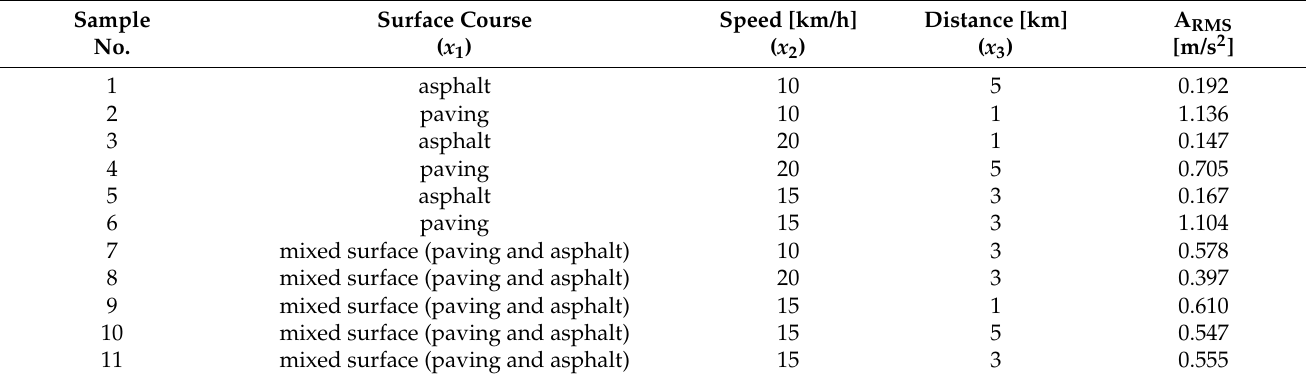
Table 2. The research plan